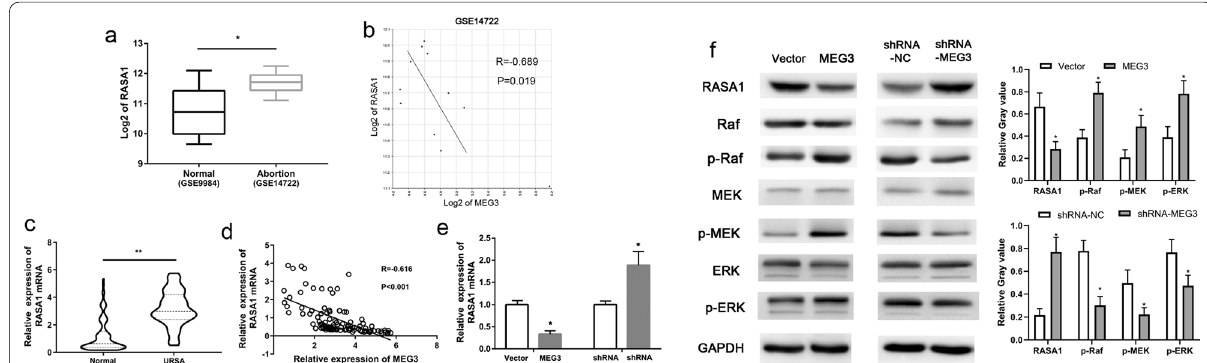
Fig. 3 MEG3 inhibited the expression of RASA1 and activated the RAS-MAPK pathway. a and b Analysis of MEG3-associated proteins using the GSE14722 data and GSE9984 data. c The expression levels of RASA1 in embryonic villi from URSA patients using qRT-PCR. d Correlation between the transcript levels of MEG3 and RASA1 in embryonic villi from URSA patients using qRT-PCR. e Effects of MEG3 on the transcript levels of RASA1 in PT-U cells using qRT-PCR. f Western blot assay: Effects of MEG3 on the RASA1 protein levels in PT-U cells, as well as the levels of Raf, MEK, and ERK proteins (ratio of phosphorylated protein to total protein) in RAS-MAPK pathway. **P < 0.01, *P <